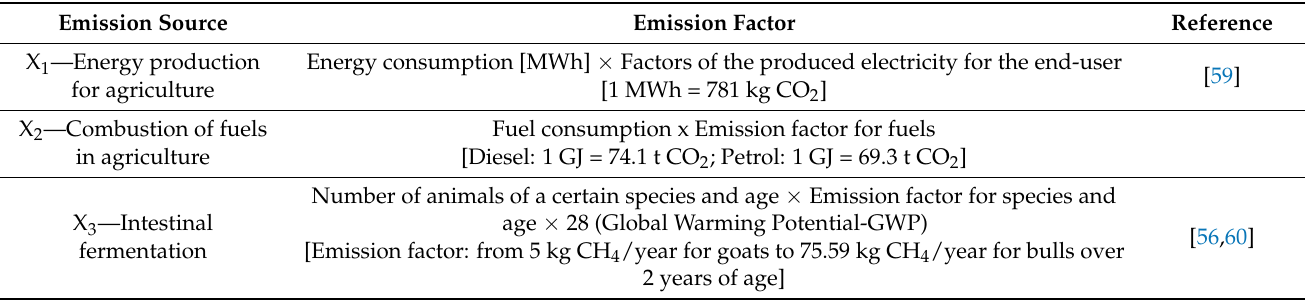
Table 4. Calculation of GHG emissions in